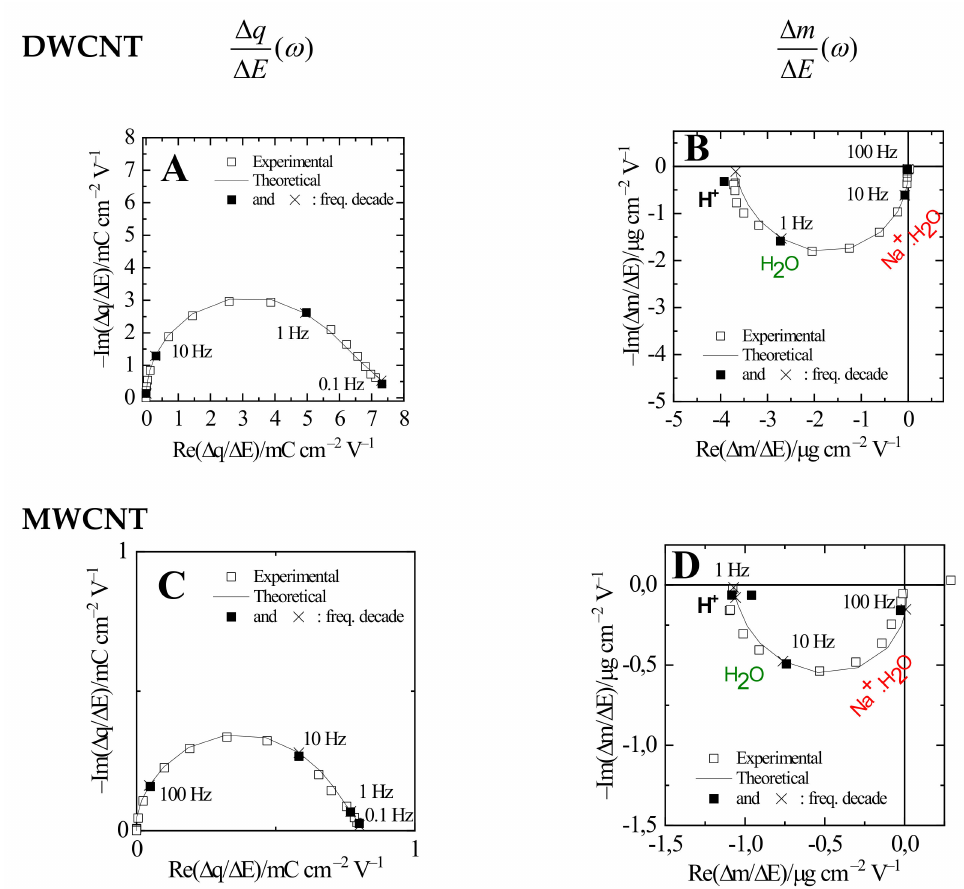
Figure 4. Experimental and theoretical AC-electrogravimetric data of the CNT thin films in 0.5 M NaCl measured at − 0.4 V vs. Ag/AgCl. ( A , C ) and Rt i are shown in Table